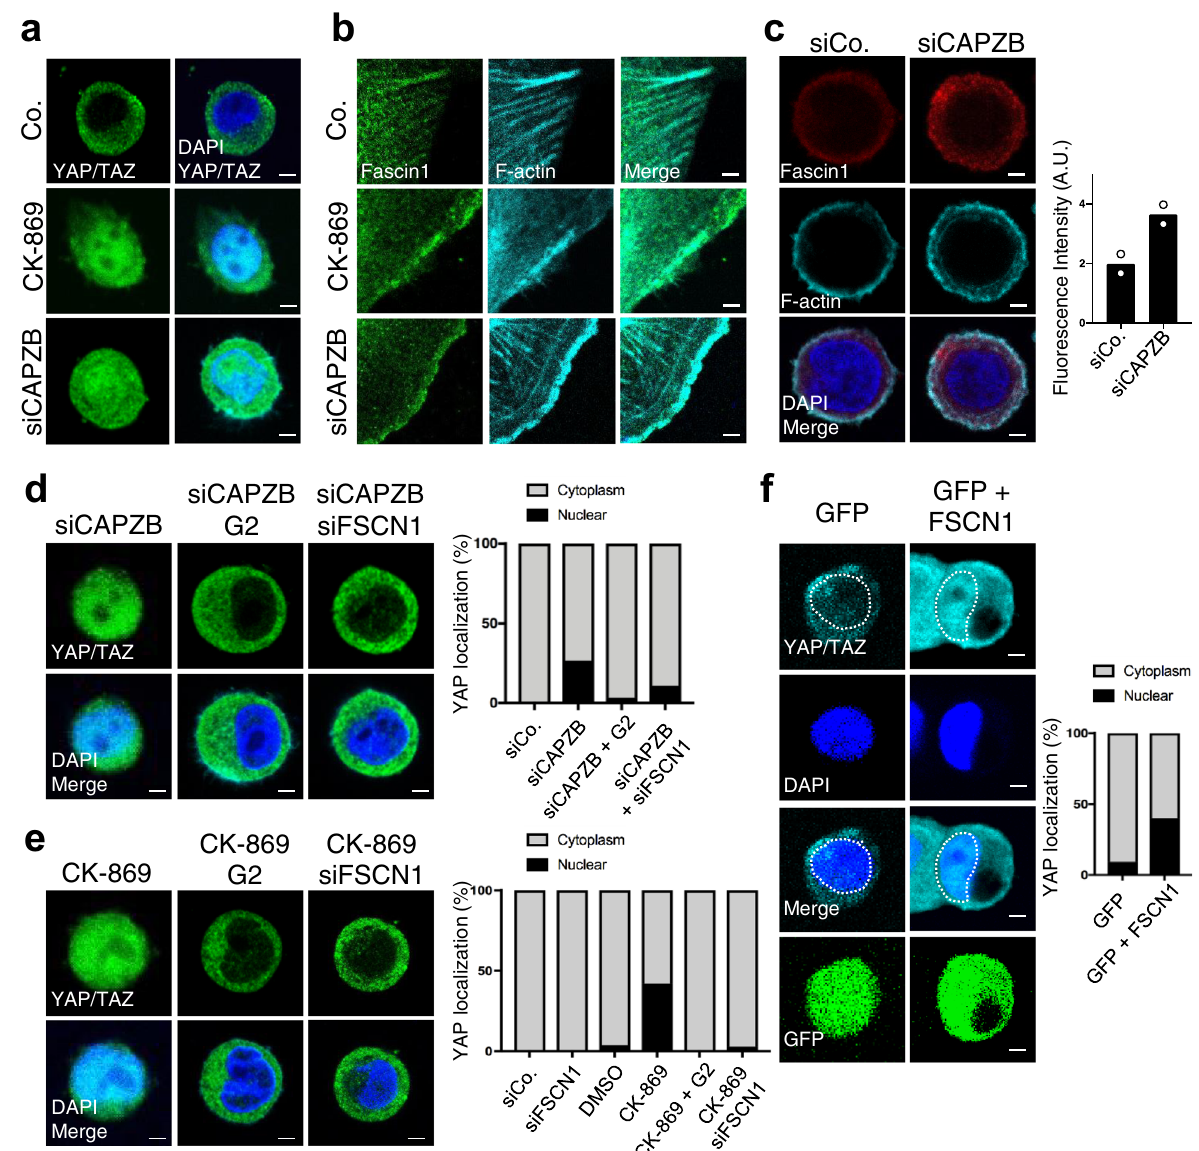
Fig. 2 CAPZB and Arp2/3 inhibition induce nuclear YAP on soft ECM substrata, which depends on Fascin1. a Representative IF of MCF10A cells